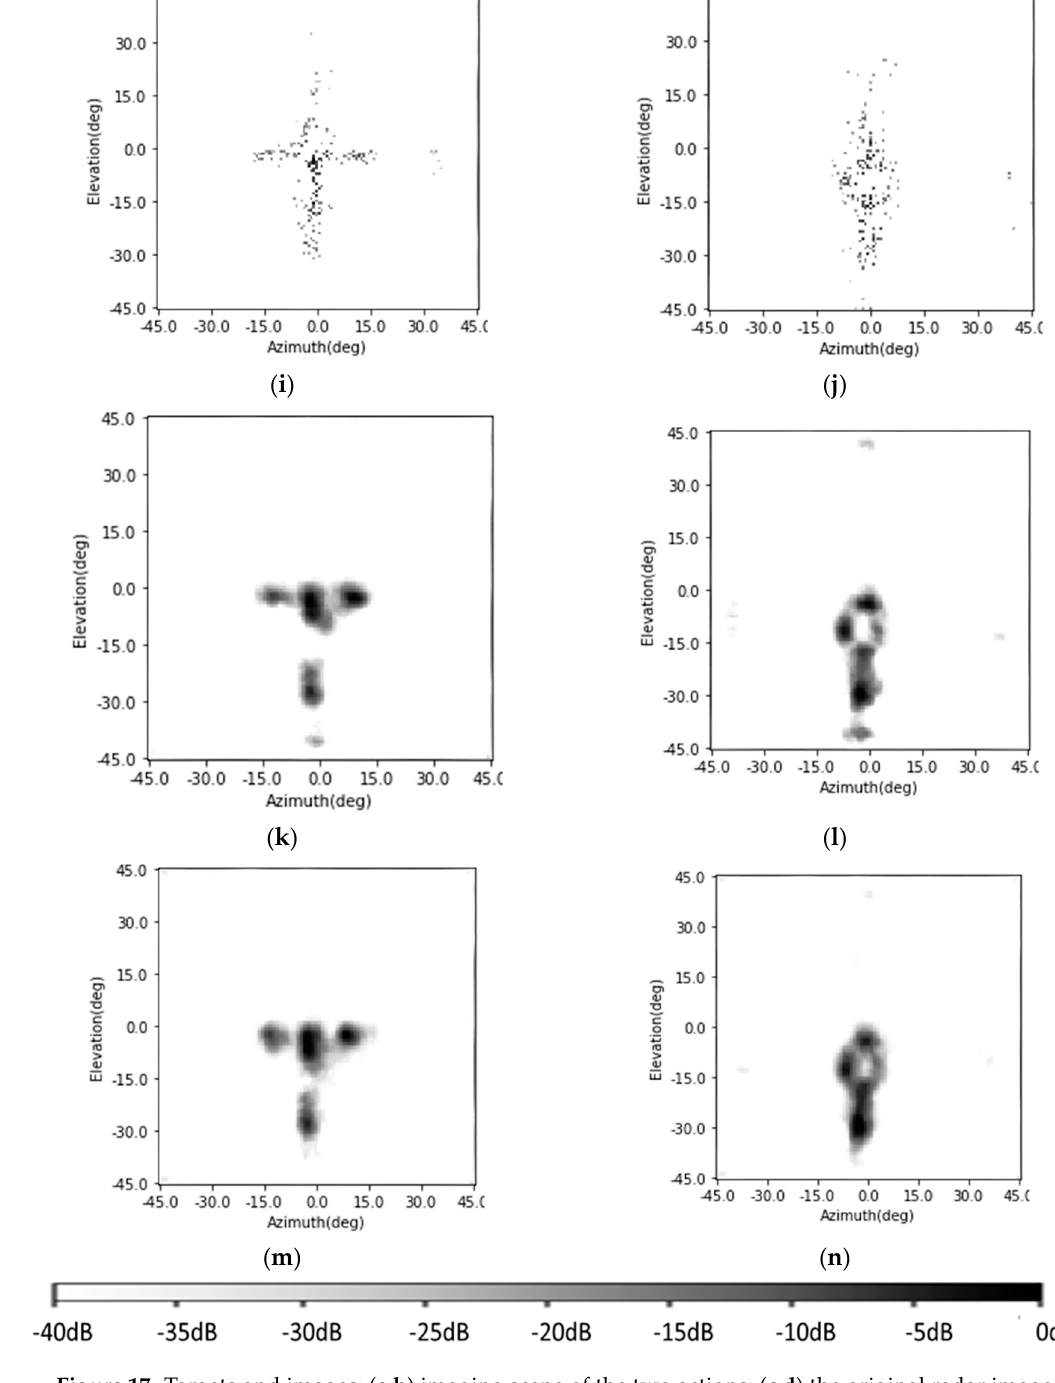
Figure 17. Targets and images; ( a , b ) imaging scene of the two actions; ( c , d ) the original radar image; ( e , f ) LR-deconv results; ( g , h ) CF results; ( i , j ) OMP results; ( k , l ) CNN results; ( m , n ) SV-CNN results.